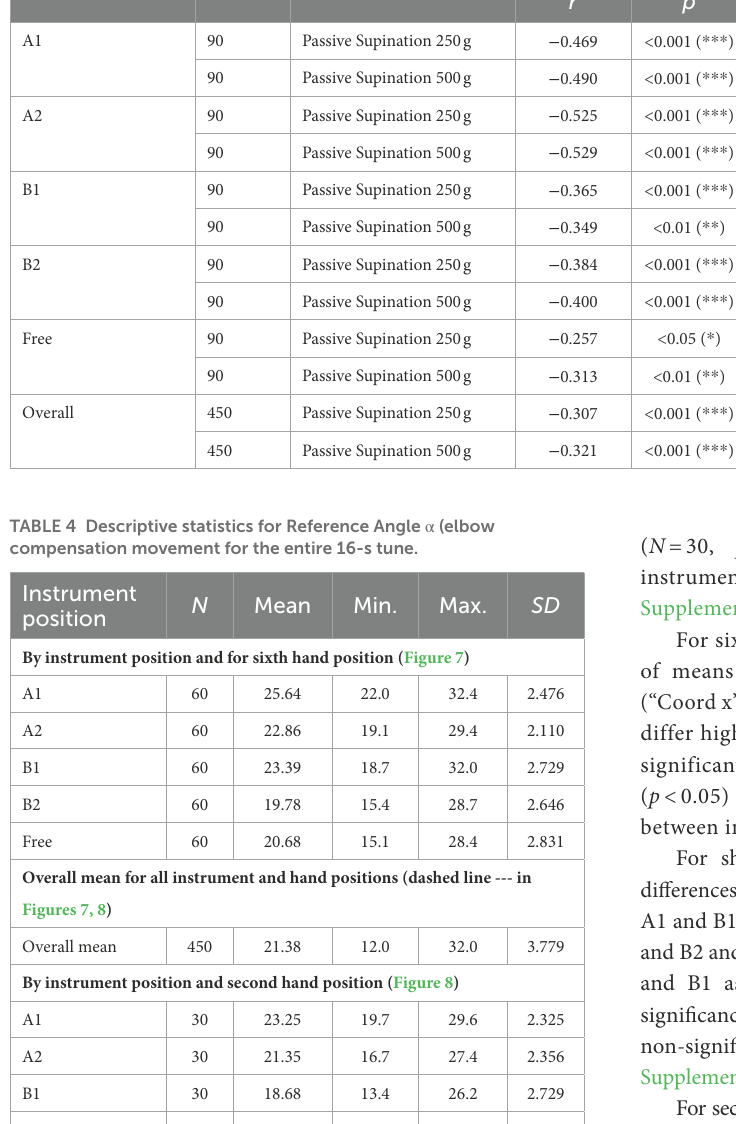
TABLE 3 Correlation analysis between biomechanical data and Reference Angle α as well as data for shoulder elevation data * p < 0.05, ** p < 0.01, and *** p < 0.001. Instrument position